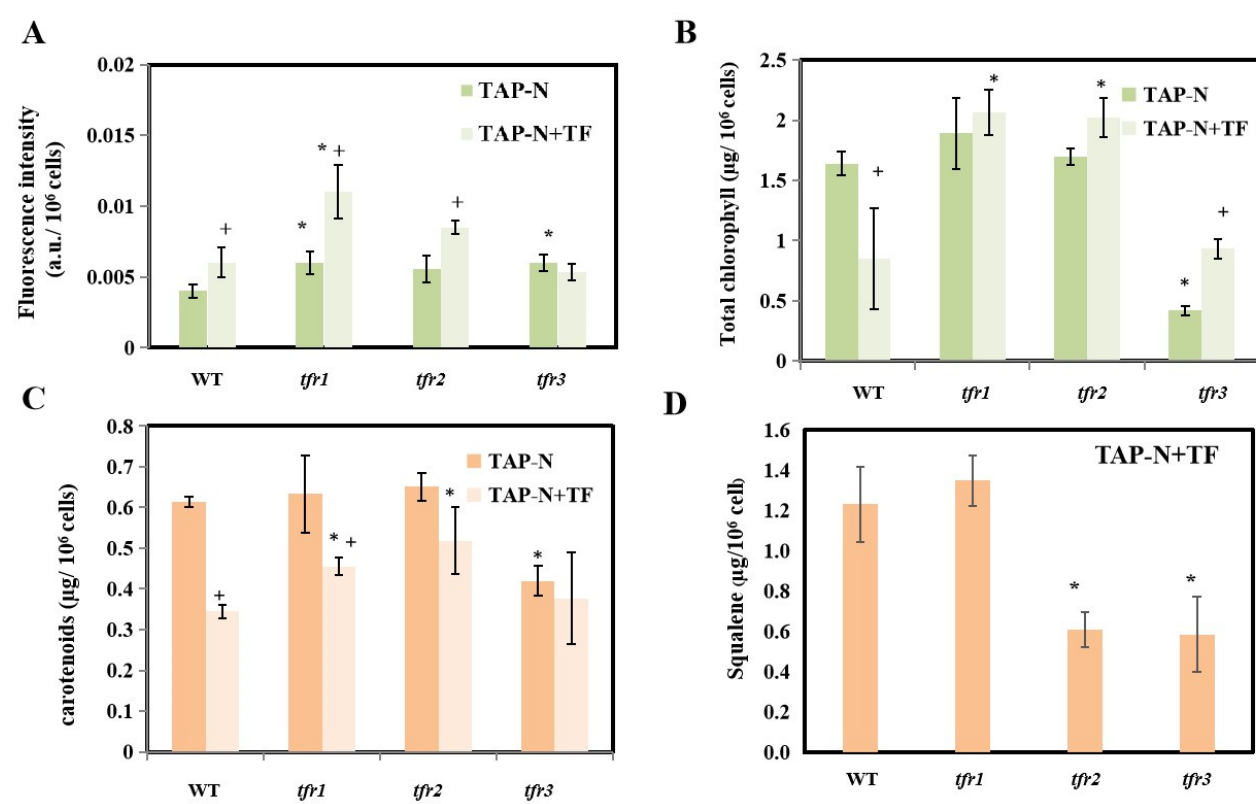
Figure 6. Quantification of triacylglycerol ( A ), chlorophyll ( B ), carotenoid ( C ) and squalene ( D ) from cultures under N-deprived condition with and without terbinafine. All data are means ± SD of three biological replicates. Significant differences between the wild type (WT) and the mutants within the same condition are indicated by asterisks (*) ( p < 0.05). Significant differences between different treatments of the same strain are indicated by plus sign (+) ( p < 0.05).